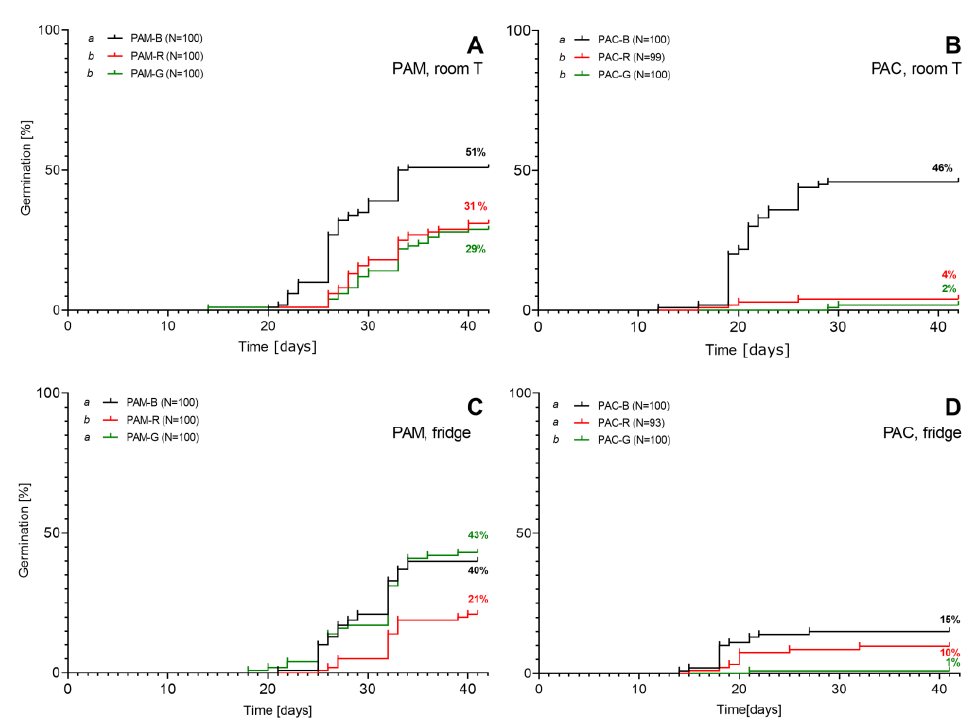
Figure 2. The germination of dried seeds of Phytolacca americana (PAM; graphs ( A , C )) and P. acinosa (PAC; graphs ( B , D )) in Petri dishes approximately 6 months after the extraction from fresh fruits of different ripeness: green (G), red (R), and black (B). Graphs (A) and (B) show the germination of sterilised seeds kept at room temperature (experiment 3). Graphs ( C , D ) show the germination of sterilised seeds kept in the fridge at 6 ◦ C (experiment 4). A log-rank (Mantel–Cox) test was used for the comparison of the survival curves. Letters a and b in legends mark statistically different curves.